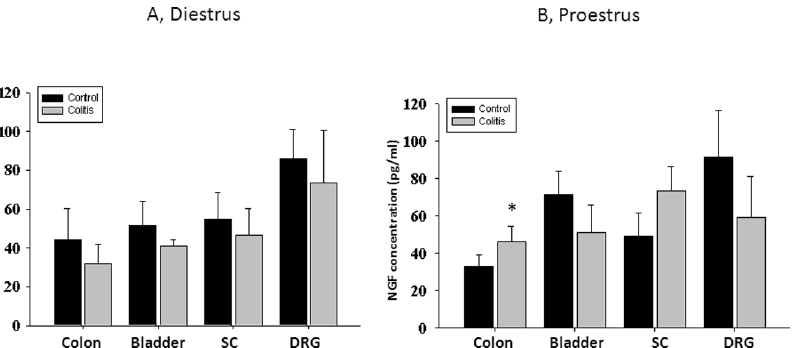
Figure 5. Limited effects of ovarian hormones on NGF concentration during colon-bladder cross-sensitization. A, Concentration of NGF protein in the distal colon, urinary bladder and neural tissues in rats during diestrus. B, NGF content during proestrus in control and TNBS-treated animals. SC- spinal cord, DRG – dorsal root ganglia. * - p # 0.05 to respective control group.